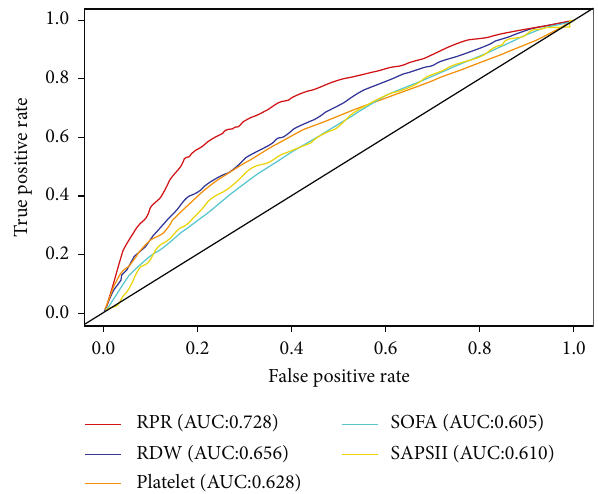
Figure 2: Receiver operating characteristics curves of RPR, RDW, platelet, SOFA, and SAPS II score for predicting 28-d mortality in patients with sepsis. The predictive ability of PRR for 28-d mortality outperformed other indices, including RDW, platelet, SOFA score, and SAPS II score by comparing the area under the curve. RPR: red cell distribution width to platelet ratio; RDW: red cell distribution width; SOFA: sequential organ failure assessment; SAPS II: simpli fi ed acute physiology score II. Table 2: Performance of red cell distribution width to platelet ratio for predicting 28-day mortality in patients with sepsis.